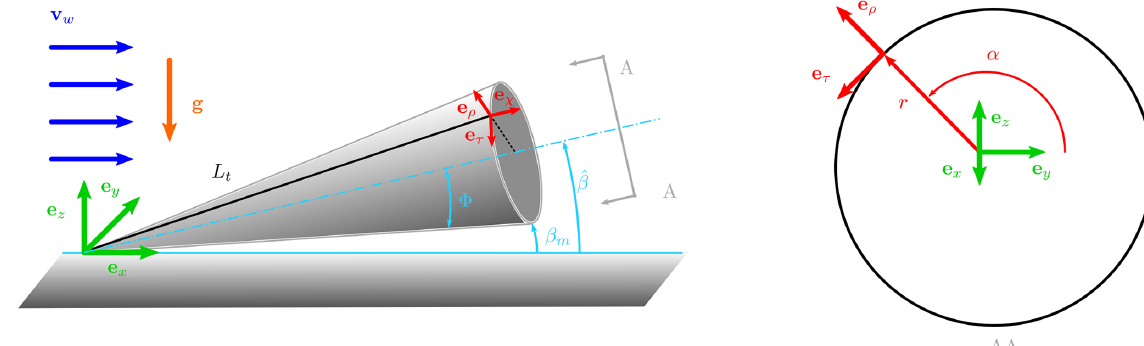
Figure 5. Cylindrical reference system F C used to analyze circular trajectories.